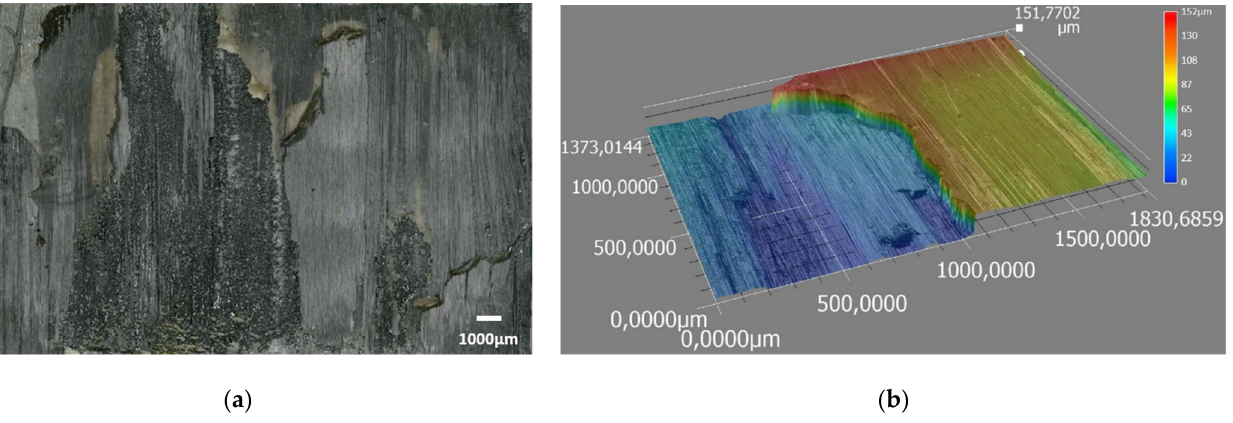
Figure 14. Optical micrographs after LSS testing of ultrasonically welded of ( a ) interfacial fracture of two layers of CF/PEEK and ( b ) colour chart corresponds to a height difference. With the PEI film at the interface, the fractured surfaces show PEI flowing along the edge of a transverse outer lap. Also, a fibre breakage in the middle of the lap was